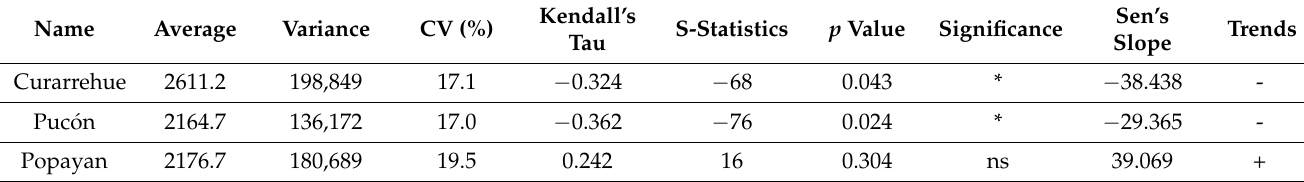
Table 2. Descriptive statistics of trends in annual precipitation (mm) between 2000 and